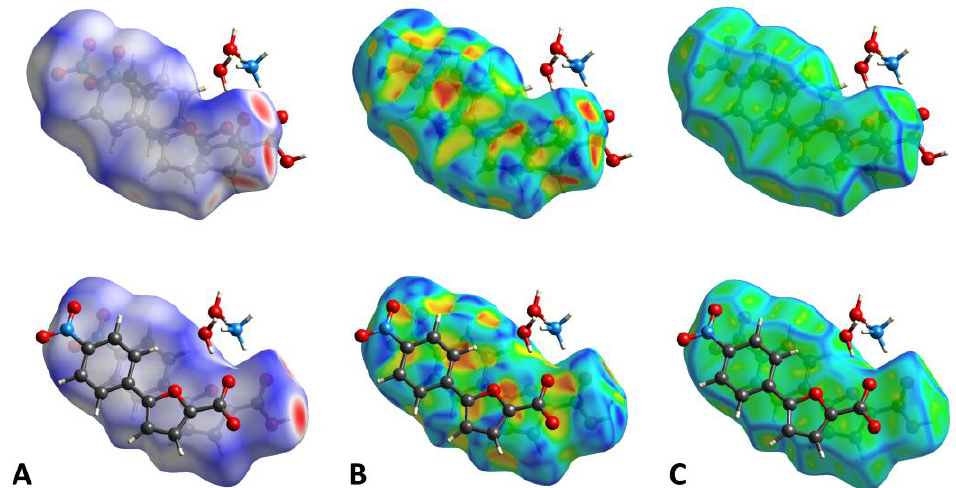
Figure 3. ( A ). HS mapped over d norm with a fixed color scale in the range −0 .8453 au (red) — 1.2461 au (blue) for the main molecule (above) and −0 .8481 au (red) — 1.2111 au (blue) for molecule A (below), based on the length of the intermolecular contacts with respect to the sum of the van der Waals radii (red: shorter; blue: longer; white: same). ( B ). HS mapped over the shape-index (color scale: −0 .9957 au — 0.9994 au for the main molecule; −0 .9882 au — 0.9924 au for molecule A). Blue areas indicate bumps, while red regions represent hollows. ( C ). HS mapped over the curvedness (color scale: −4 .0490 au — 0.4420 au for the main molecule; −3 .8574 au — 0.3755 au for molecule A). Flat regions are colored green, while edges are blue.